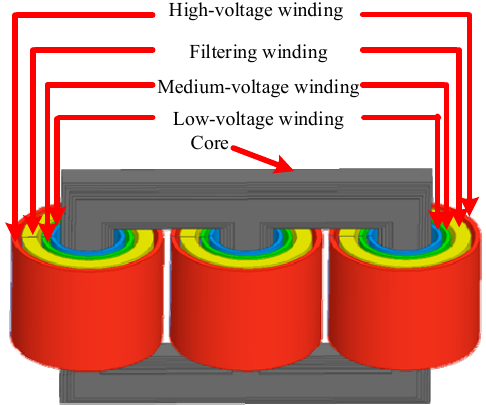
Figure 2. Wiring scheme of the FW-IFT and passive filters.